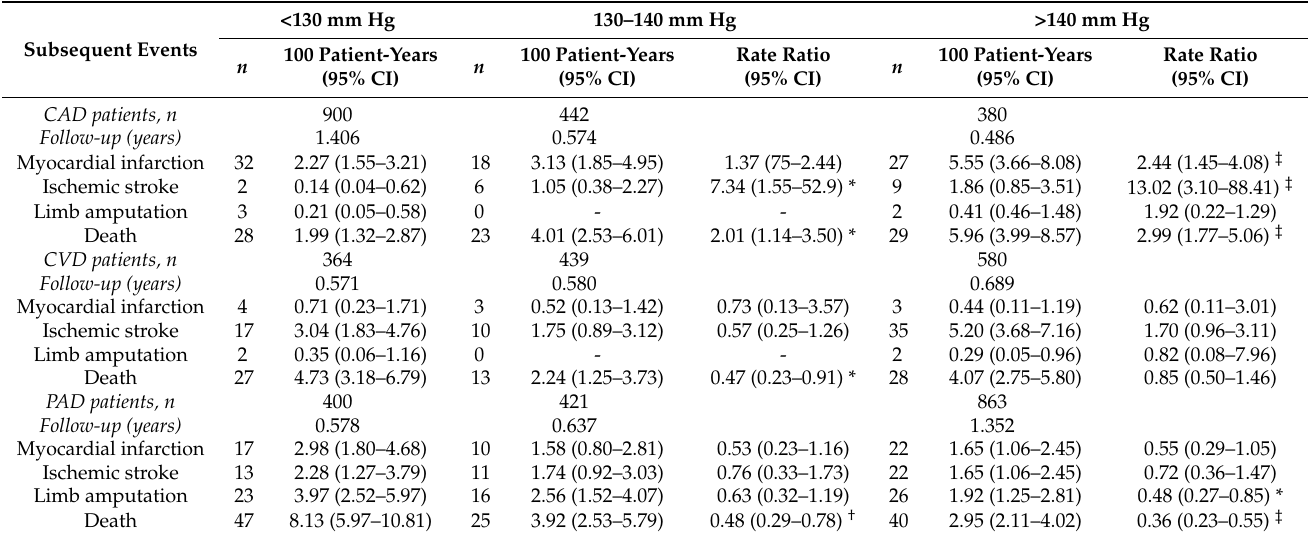
Table 2. Incidence rates (per 100 patient-years) of subsequent ischemic events and death, according to mean SBP levels during follow-up.